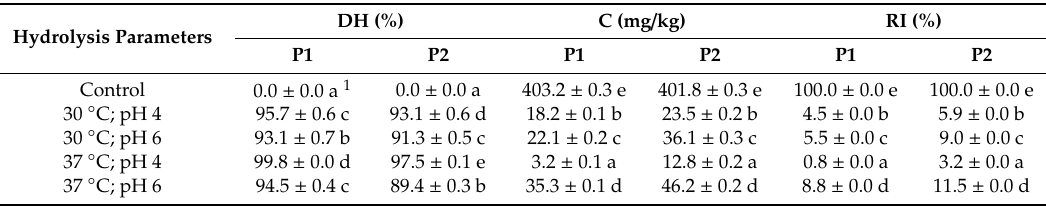
Table 4. E ff ect of reaction conditions on the degree of hydrolysis (DH, %), concentration of QQPFP sequence (C, mg / kg) and relative immunoreactivity (RI, %) of hydrolysed peptides: LGQQQPFPPQQPY (P1) and PQPQLPYPQPQLP (P2) by a mixture of peptidases from L. acidophilus 5e2 and A. niger after 3 h of incubation.